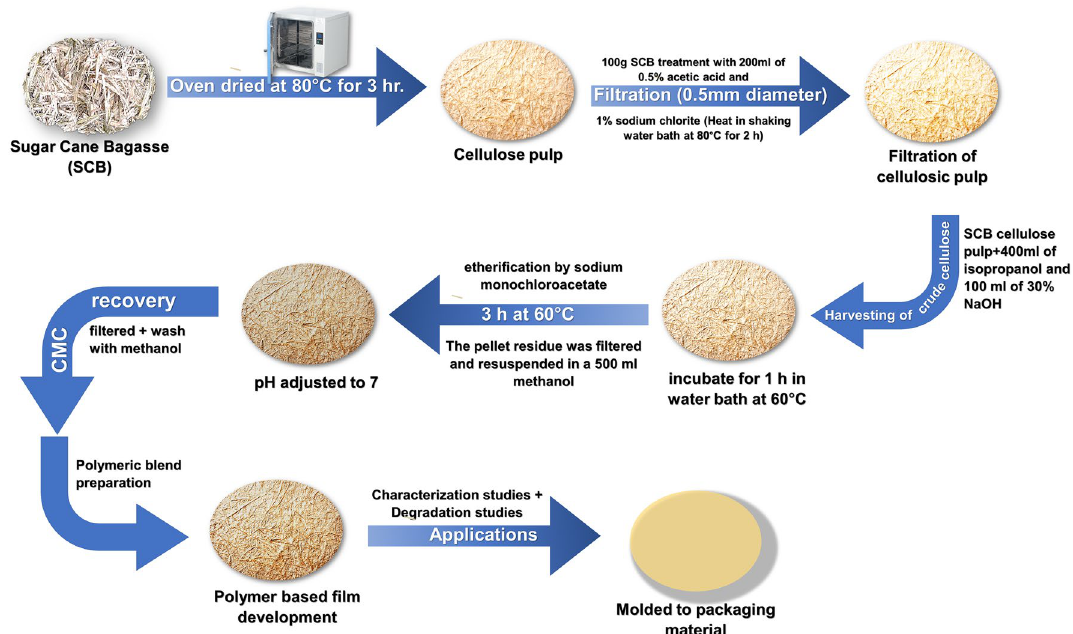
Figure 6. Schematic representation of the development of Biodegradable plastic for sustainable